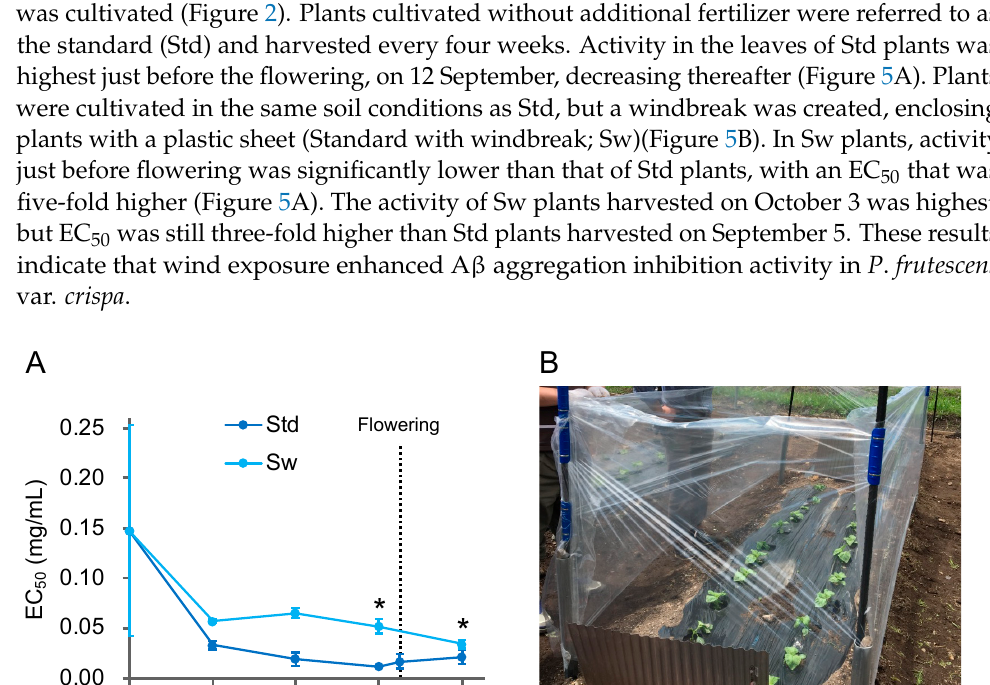
Table 1. Multiple Fertilization Conditions in 2019.